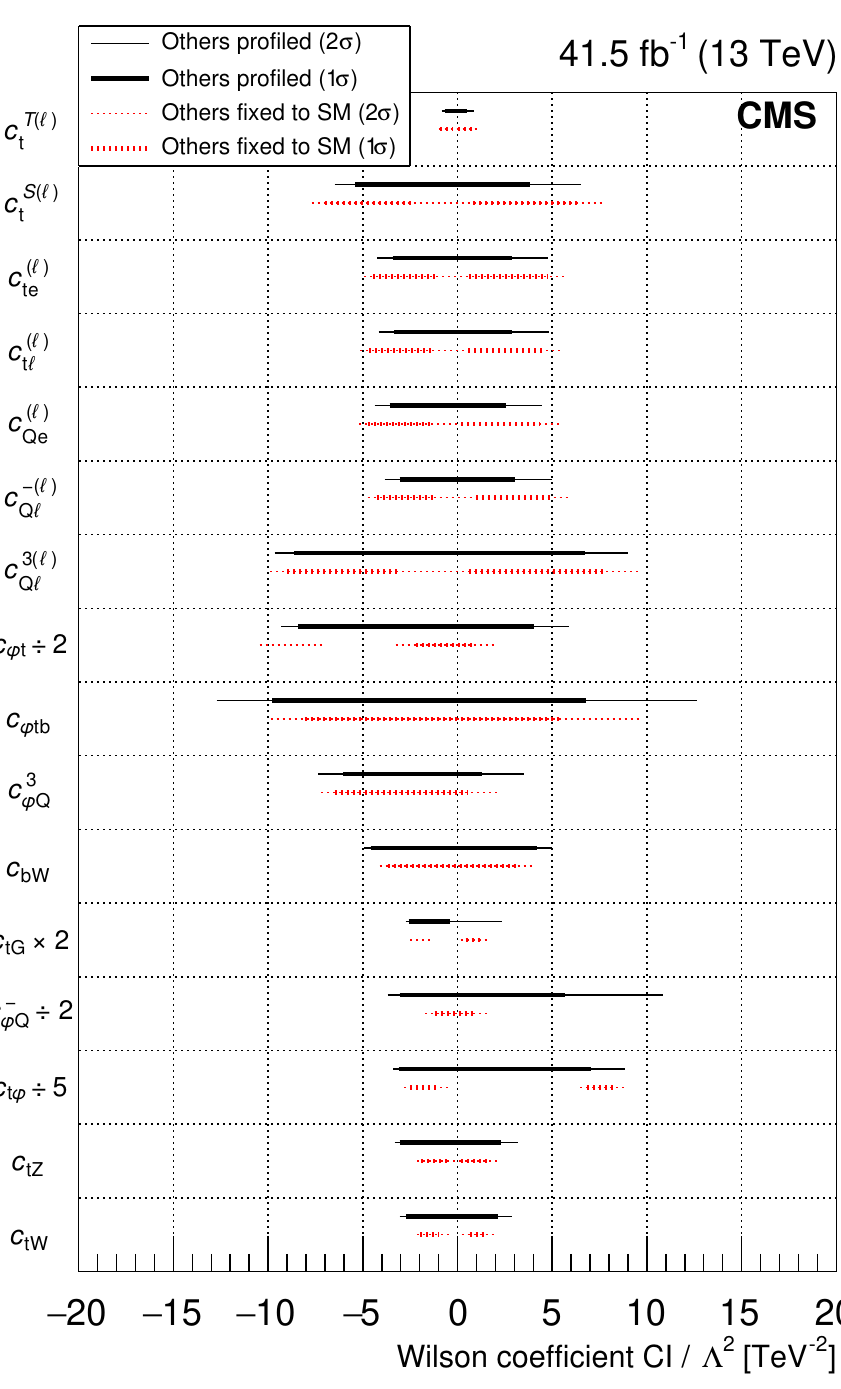
Figure 4 . Observed WC 1 σ (thick line) and 2 σ (thin line) confidence intervals (CIs). Solid lines correspond to the other WCs profiled, while dashed lines correspond to the other WCs fixed to the SM value of zero. In order to make the figure more readable, the c interval is scaled by 1 / 2 , the ϕ t interval is scaled by 2, the c − interval is scaled by 1 / 2 , and the c interval is scaled by 1 / 5 c t ϕ t G ϕQ